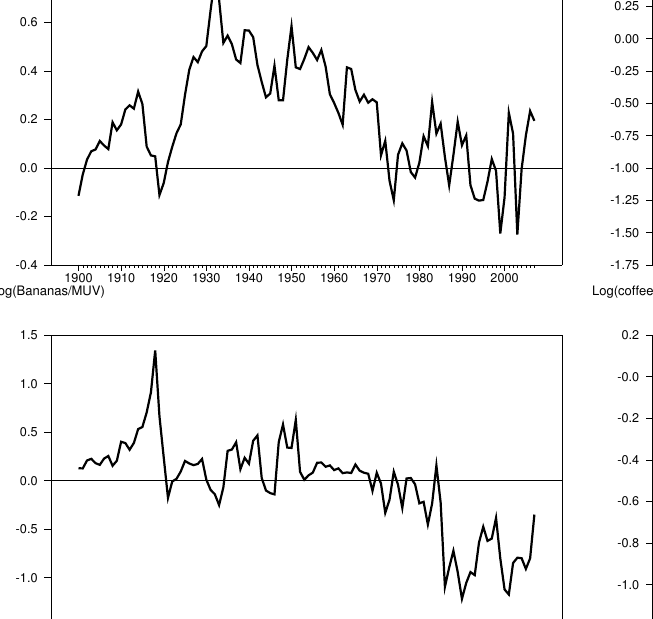
Figure 4. A plot of y it = log